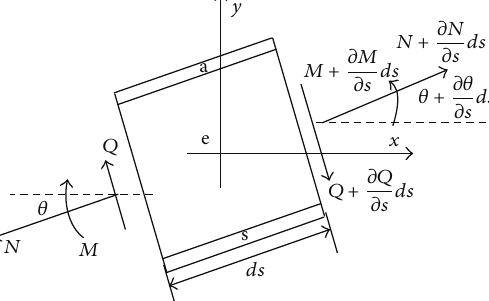
Figure 3: A piezoelectric bimorph cantilever beam.